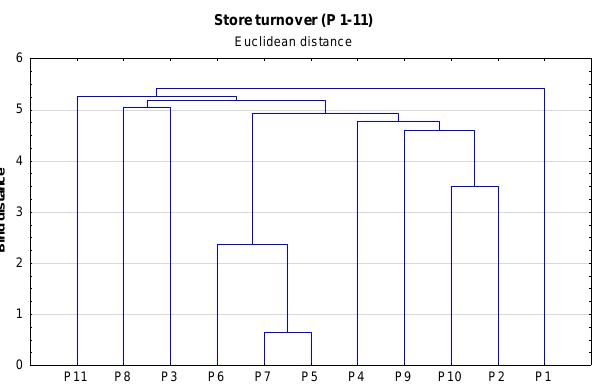
Figure 1. Tree diagram for respondents ’ views of food turnover in stores.